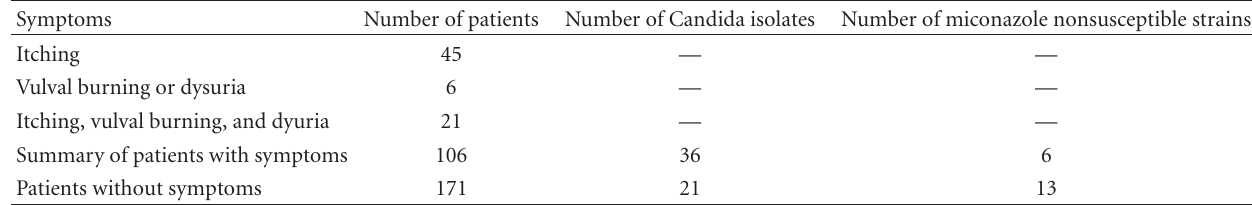
Table 1: Candida isolates in patients without ( n = 171) or with di ff erent symptoms of vulvovaginitis ( n = 106) all with previous miconazole treatment.